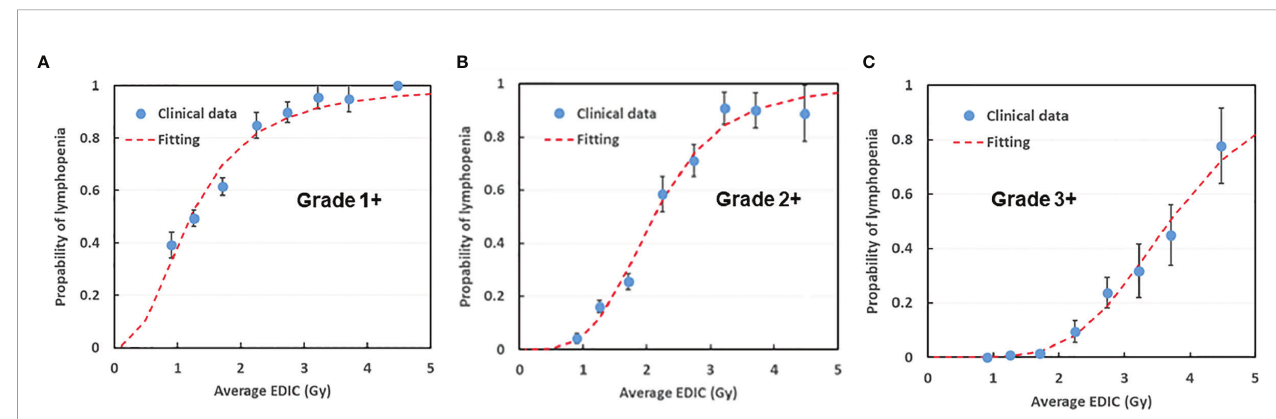
FIGURE 4 | EDIC NTCP model for (A) Grade 1+, (B) Grade 2+ and (C) Grade 3+ postRT lymphopenia. Patients were divided into 8 groups with a 0.5 Gy increment in each group (<1, 1-1.5, 1.5-2, 2-2.5, 2.5-3, 3-3.5, 3.5-4, >4.5). NTCP, Normal Tissue Complication Probability. EDIC, Effective Dose to the circulating Immune